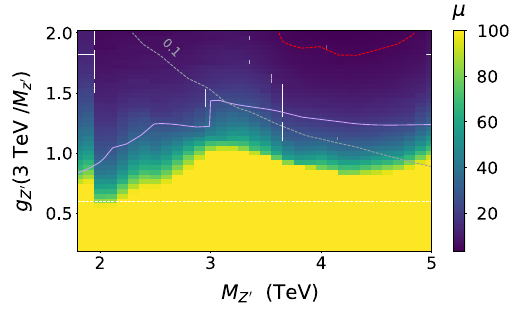
Fig. 15 μ fortheATLASdi-topsearch[67]ateachpointinthescanned parameter space. The current search does not constrain the model. The dashed red line shows our estimate of the HL-LHC sensitivity. The solid purple line shows the current observed bound from all searches considered in this work. The dashed grey line shows the contour where (cid:10)/ M = 0 . 1 , and the region between the dashed white line and the Z (cid:2) bottom of the plot is favoured by the flavour and electroweak data at the 95% CL. Toward the extreme left-hand side of the plot, our predictions become more inaccurate due to unaccounted-for O ( M 2 corrections